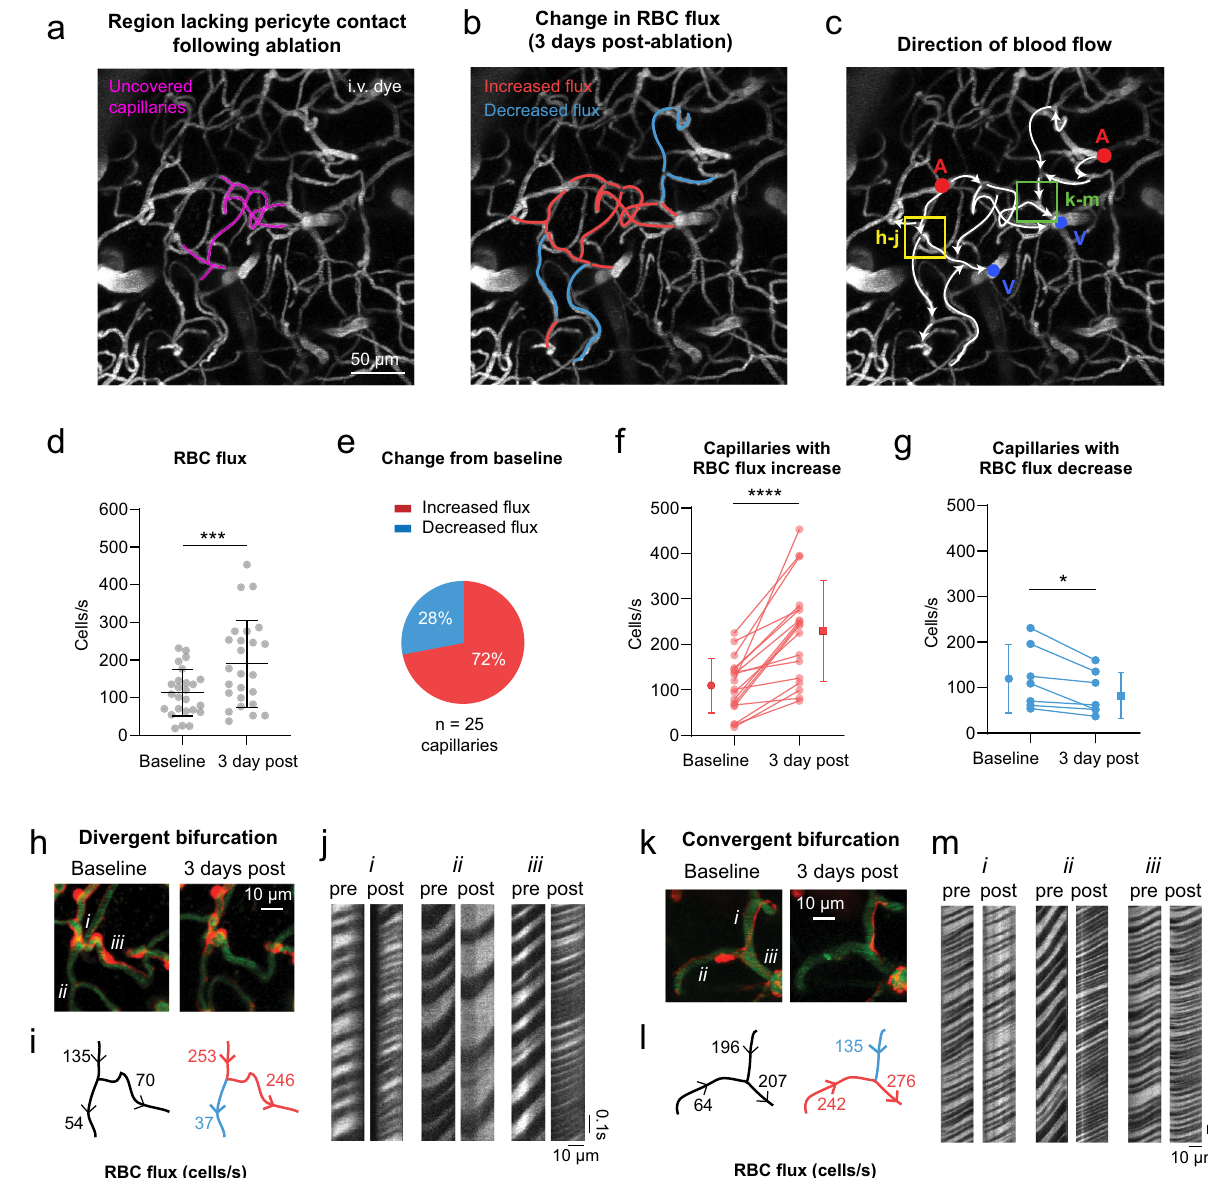
Fig. 7 | Blood fl ow changes in regions of pericyte ablation and surrounding capillaries. a Image showing capillaries uncovered by a triple ablation (purple). These data are from a single triple pericyte ablation experiment, performed in an agedmouse. I.v. dye = intravenous dye. b Three days post-ablation, changes in red bloodcell(RBC) fl uxfrombaselinearecolor-codedinasubsetofvessels. c Overlay of blood fl ow direction on vascular image. Ascending venules are marked in blue, and penetrating arterioles in red. d Blood cell fl ux before and 3 days post ablation for segments in and immediately around the ablation area. Paired t test, t (24) =3.880;*** p =0.0007for n =25capillariesfromanagedmouse.Signi fi cantlyhigher variancewasdetectedat3 days compared to baseline, F test to comparevariances (two-sided), F (24,24)=3.545;*** p =0.0029.Datashownasmean±SD. e